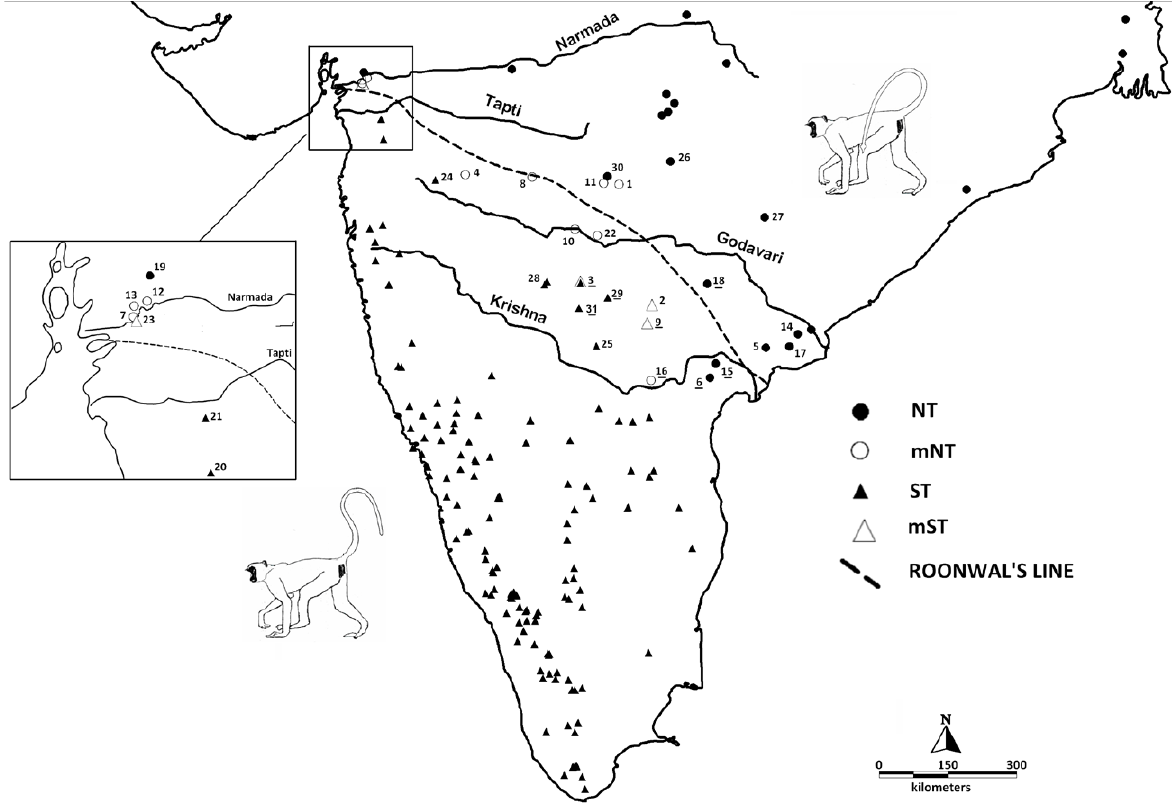
Figure 1. Locations of troops up to 200km on either side of Roonwal’s line and the tail type observed in these troops. Underlined numbers show locations of areas wherein human mediated translocations of langurs were reported. See Table 1 for the names of these